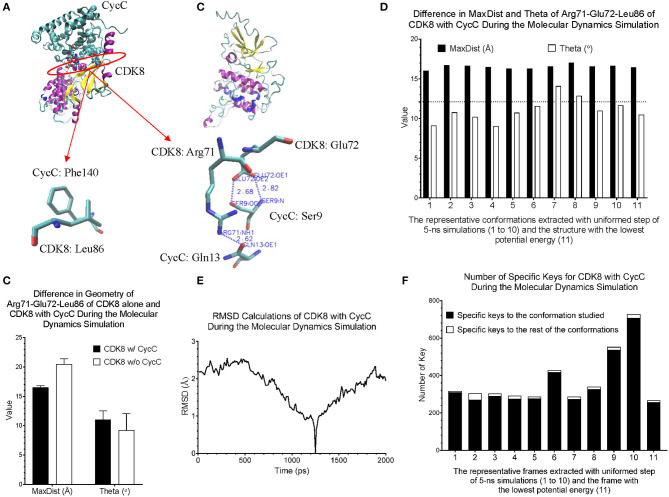
Our method can detect fine structural changes of CDK8 upon binding of CycC. (A) The crystal structure of CDK8 and CycC complex is shown (PDB ID: 3RGF). The interface between CDK8 and CycC is labeled. The hydrogen bonds and van der Waals interactions between CDK8 and CycC are shown; (B) The frame of CDK8 having the lowest potential energy was extracted from 5-ns MD simulation and is shown; (C) The MaxDist and Theta of the triangle of Arg71-Glu72-Leu86 of CDK8 alone and CDK8 with CycC were calculated. Mean ± SD are indicated; (D) Ten frames from the uniformed steps of 200-ps simulations were extracted and they are named as frames 1–10. The frame of CDK8 with the lowest potential energy is labeled as frame 11; (E) RMSD values of CDK8 in the complex of CDK8 and CycC were calculated using its frames with the lowest potential energy during 200-ps MD simulations as the references, (F) The numbers of specific keys exclusively belonging to each of the 11 frames (1–11) of CDK8 were calculated and are presented. The numbers of specific keys exclusively belonging to all frames, except for the one frame indicated, were also calculated and are presented. The frame with the lowest potential energy is labeled as 11.